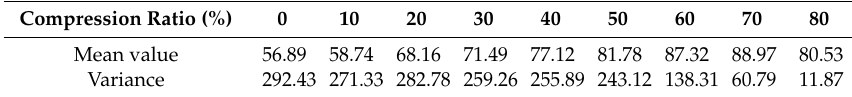
Table 3. The calculated mean value and variance of sound absorption coefficients in the frequency range of 1000 Hz to 6000 Hz for the Ni-Fe samples with different compression